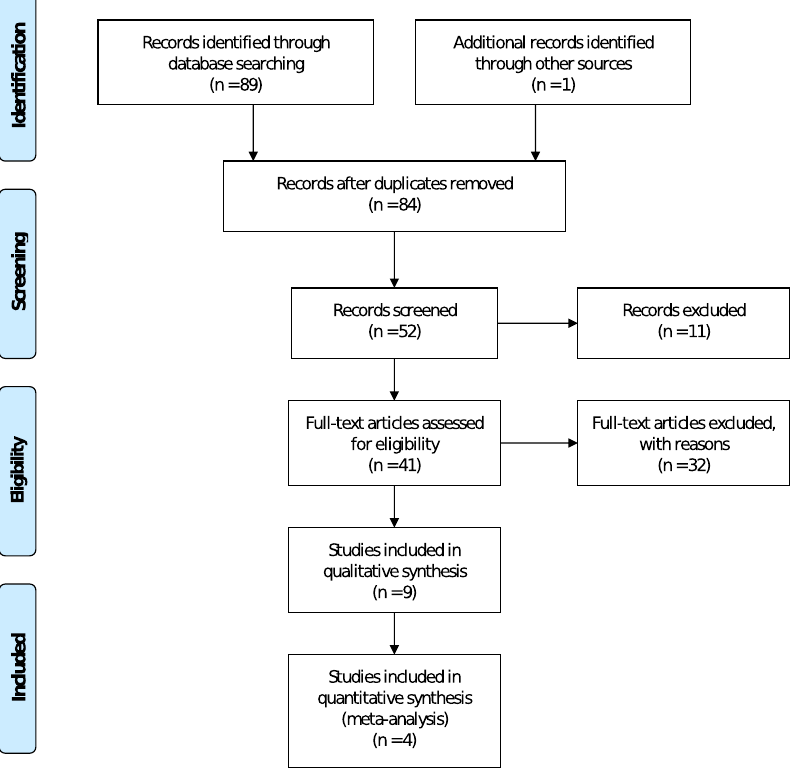
Figure 1: PRISMA flow diagram of the literature search